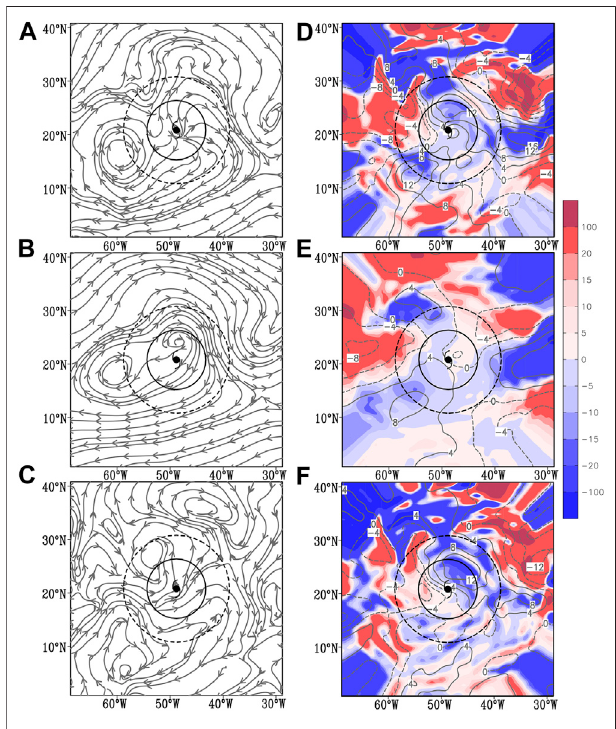
FIGURE 12 | As in Figure 7 but for 200